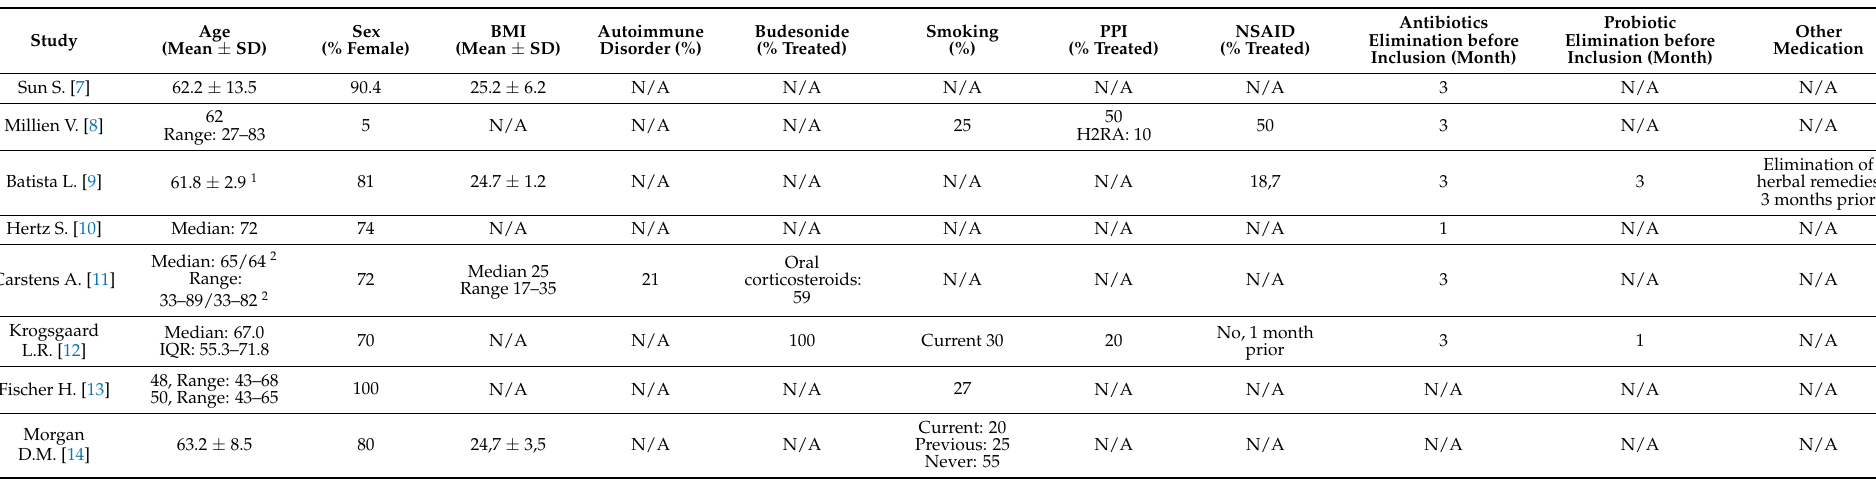
Table 2. Description of the study populations suffering from microscopic colitis: microbiome (n =